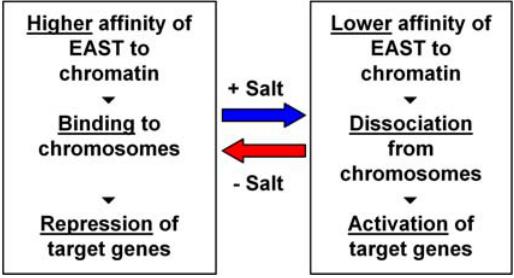
Figure 6. EAST might act as a salt sensor that modulates gene expression in response to changing ion (Na + /K + ) concentrations. A change in EAST dosage may lead to the sensing of incorrect ion levels, which may result in inappropriate physiological